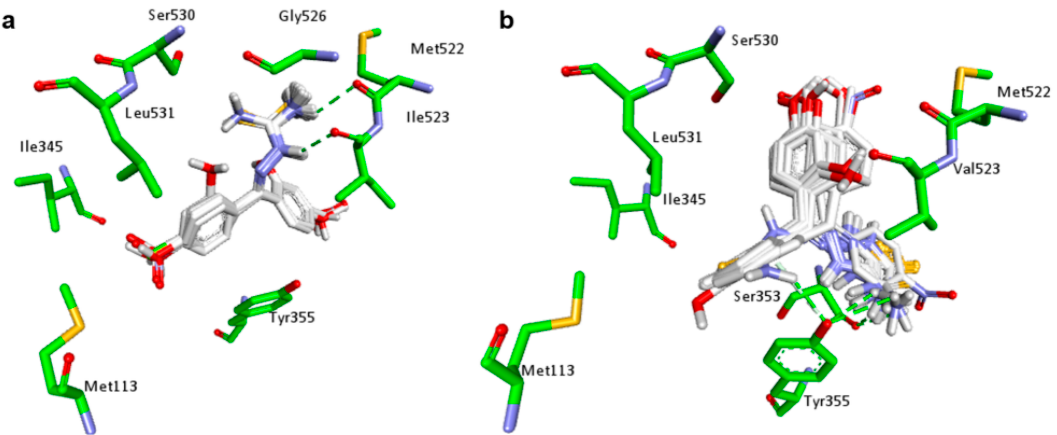
Figure 5. Docking results of 2a – 2j isomers into COX isoenzymes active sites. ( a ) Conformation of cited compounds (white carbons, yellow sulfurs, blue nitrogens and red oxygens) found in their most stable complex with COX-1 (PDB ID: 2OYU) (green carbons); ( b ) Conformation of cited compounds found in their most stable complex with COX-2 (PDB ID: 3NT1). Hydrogen bonds (dotted green line) are indicated.